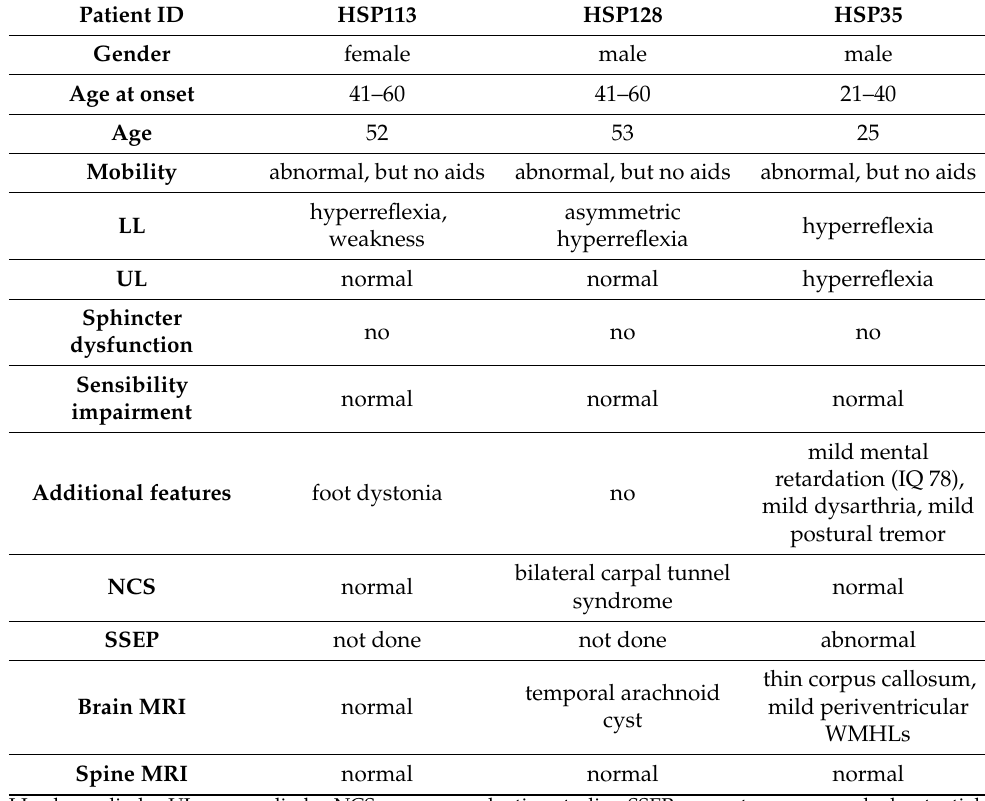
Table 3. Clinical findings of Serbian patients with genetically confirmed SPG11.